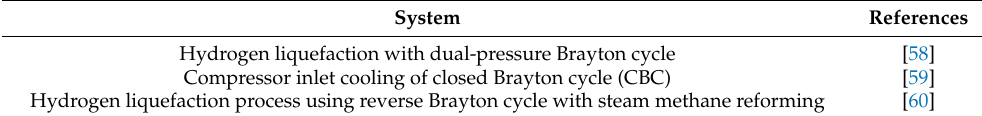
Table 2. Other works utilizing LNG cold energy for Brayton cycle in power